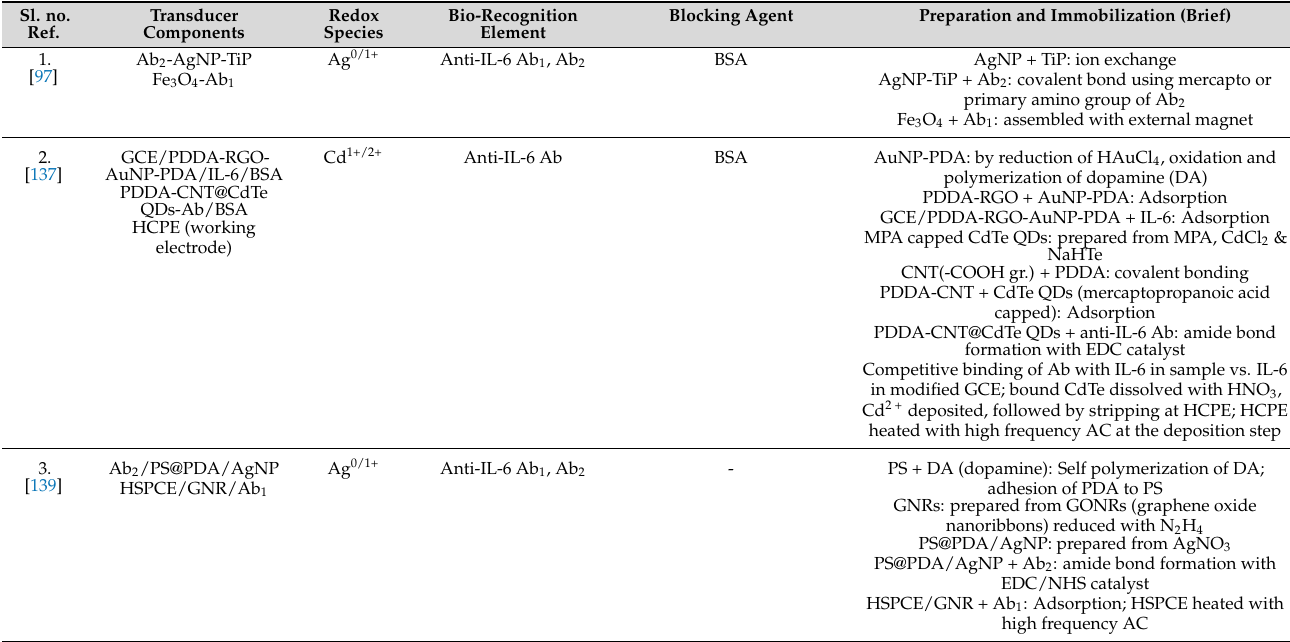
parameters are presented on Tables 7 and 8. Table 7. Heavy metal nanoparticle ‐ labeled immunosensors: Design and sensor preparation. Table 7. Heavy metal nanoparticle-labeled immunosensors: Design and sensor preparation. Sl. no. Sl. no. Ref.